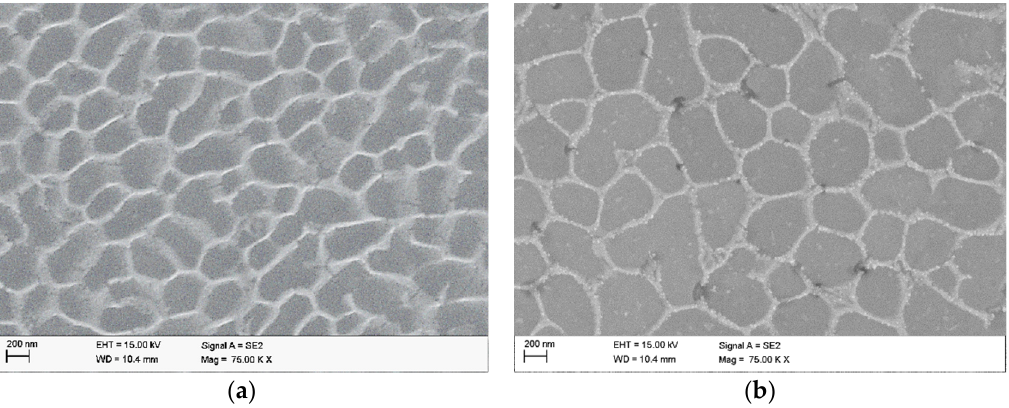
Figure 3. Microstructure of sample from SEM ( a ) SLM; ( b ) HT280.